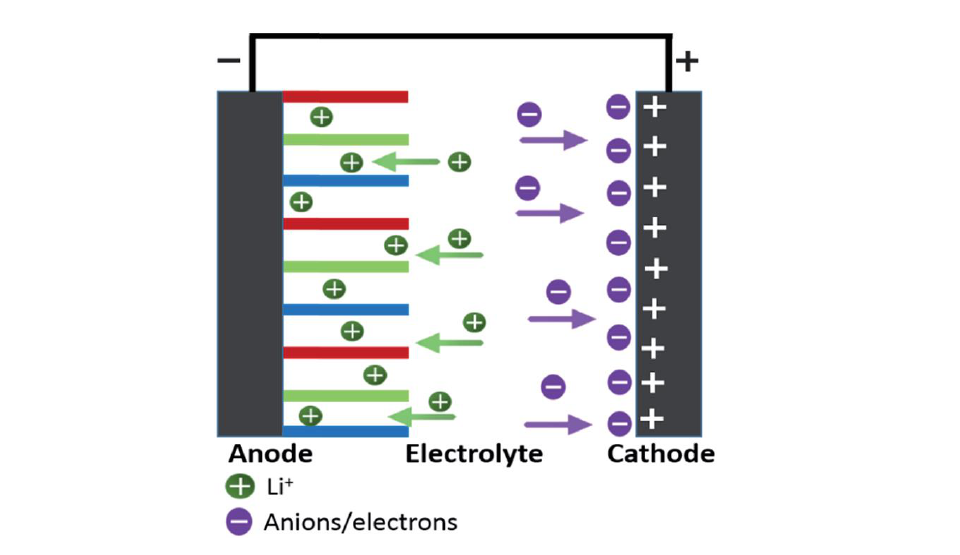
Figure 3. Mechanism of working lithium-ion capacitor.